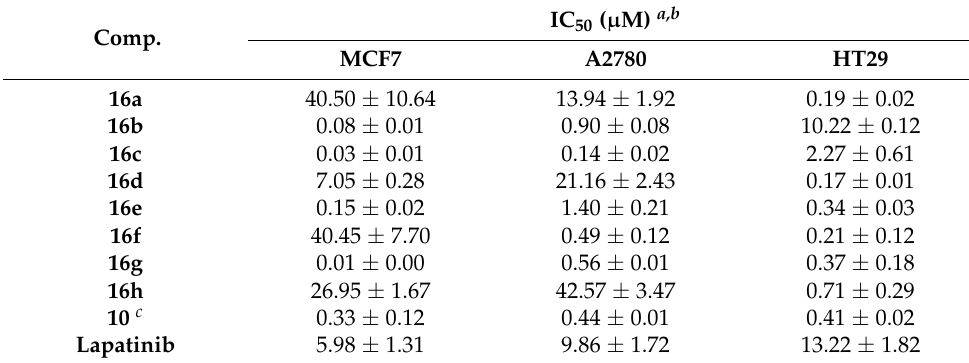
Table 2. Antiproliferative activity of compounds 10 , 16a – h , and lapatinib against MCF-7, A2780, and HT29 cancer cell lines.